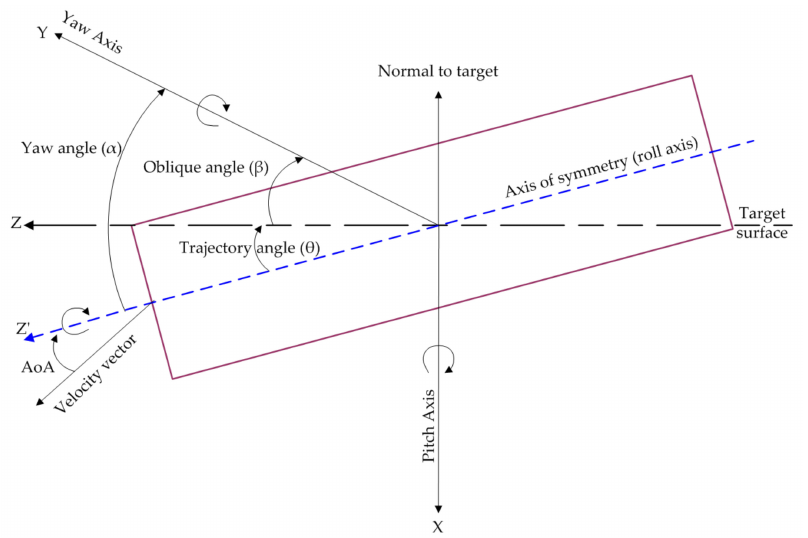
Figure 3. Definition of angle of attack (AoA), oblique angle, yaw angle, and trajectory angle.